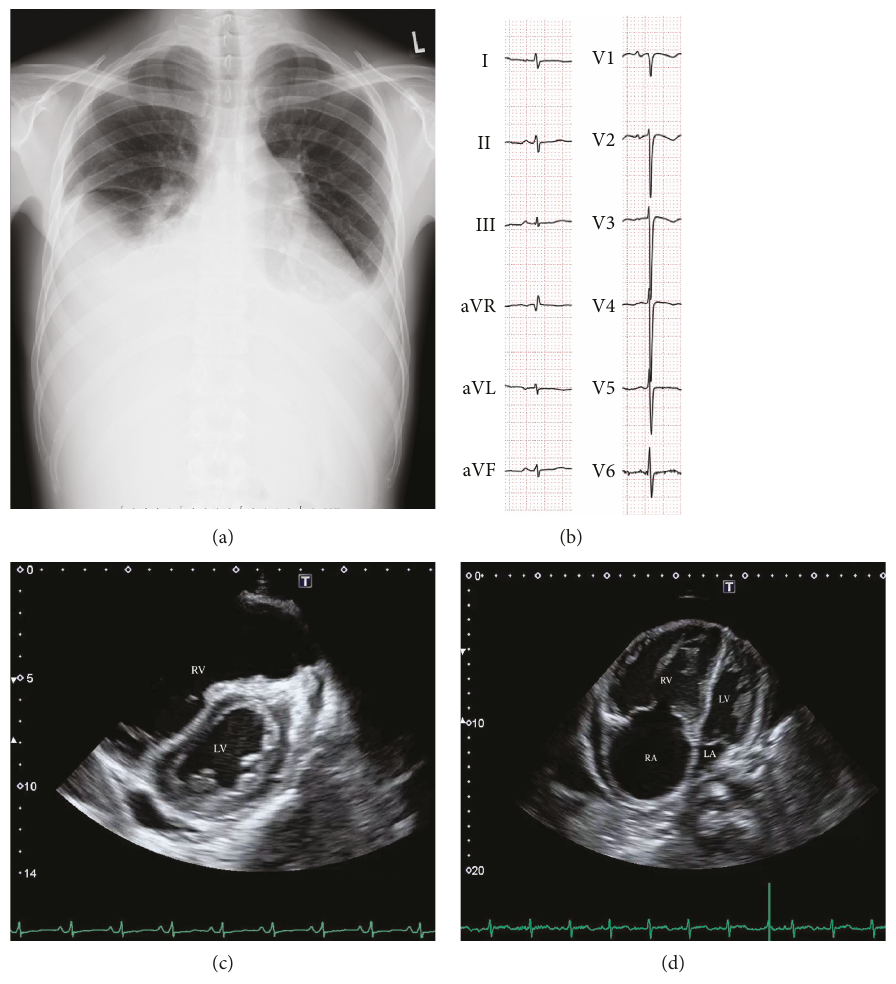
Figure 1: Clinical images on admission leading to diagnosis of pulmonary artery hypertension. (a) Chest X-ray on admission showed cardiac enlargement and severe bilateral plural e ff usion. (b) ECG suggested mild right ventricular overload and clockwise rotation. (c) Short axis view of the TTE showed fl attening of the interventricular septum. (d) Apical four-chamber view of the TTE showed decreased left ventricular chamber size pressured by enlarged right ventricle. TTE: transthoracic echocardiography; LV: left ventricular; LA: left atrium; RV: right ventricular; RA: right